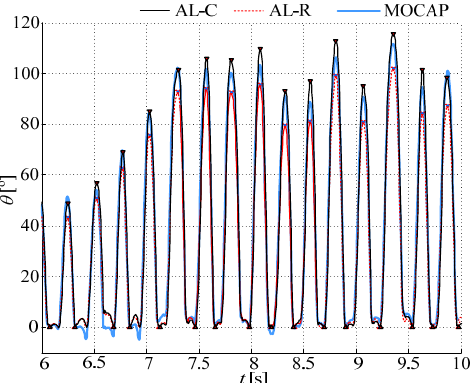
Figure 5. Tapping angle obtained from gyro sensors (with removed baseline) using the continuous (AL-C, black solid line) and resetting (AL-R, red dotted line) algorithms, and angle obtained from motion capture system (MOCAP, blue solid line). Shown is an example for one subject performing task #2 (fast and wide).